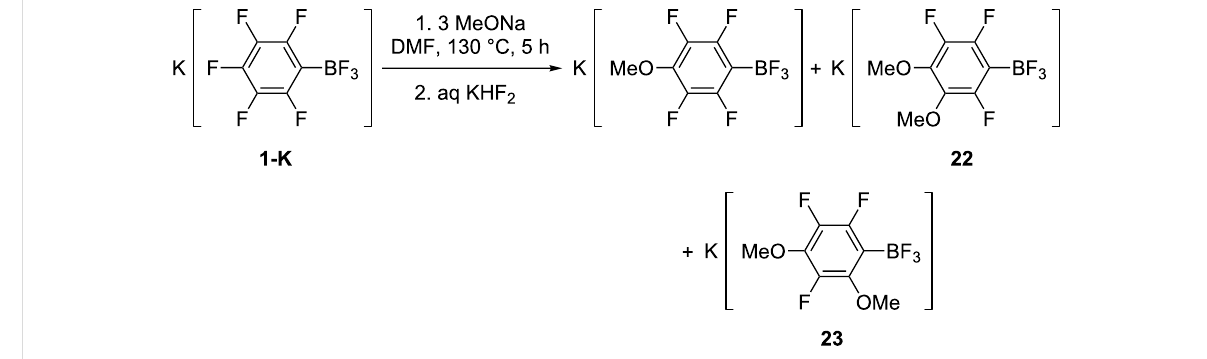
Scheme 11: Interaction of 1-K with MeONa.